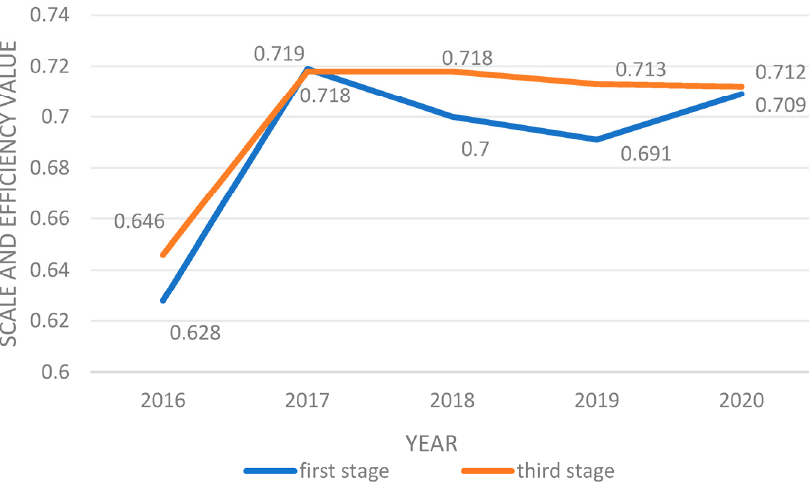
Figure 7. Comparison of the scale and efficiency of the Yangtze River Delta port group.